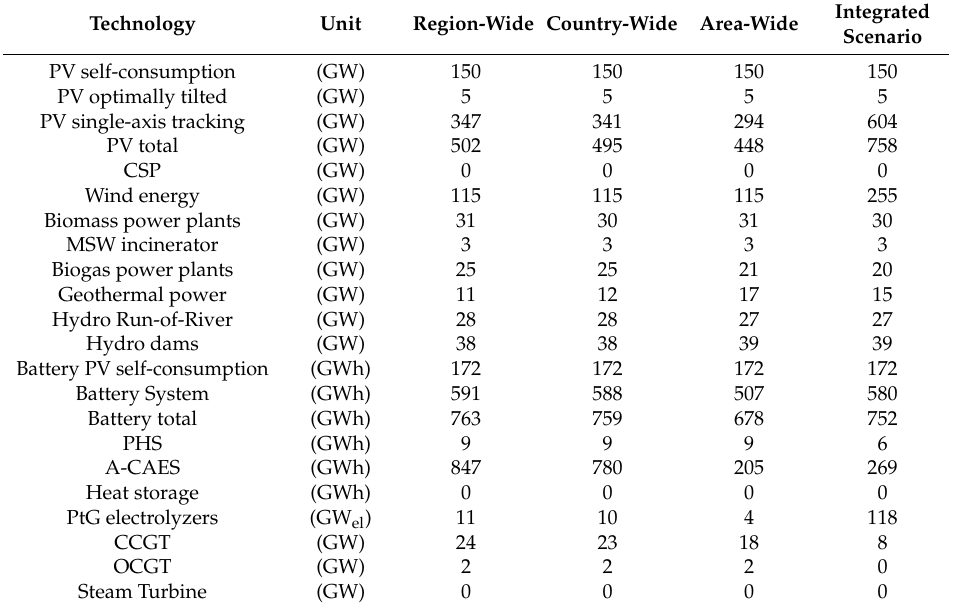
Table 5. Results on the installed RE technologies and storage capacities for the four